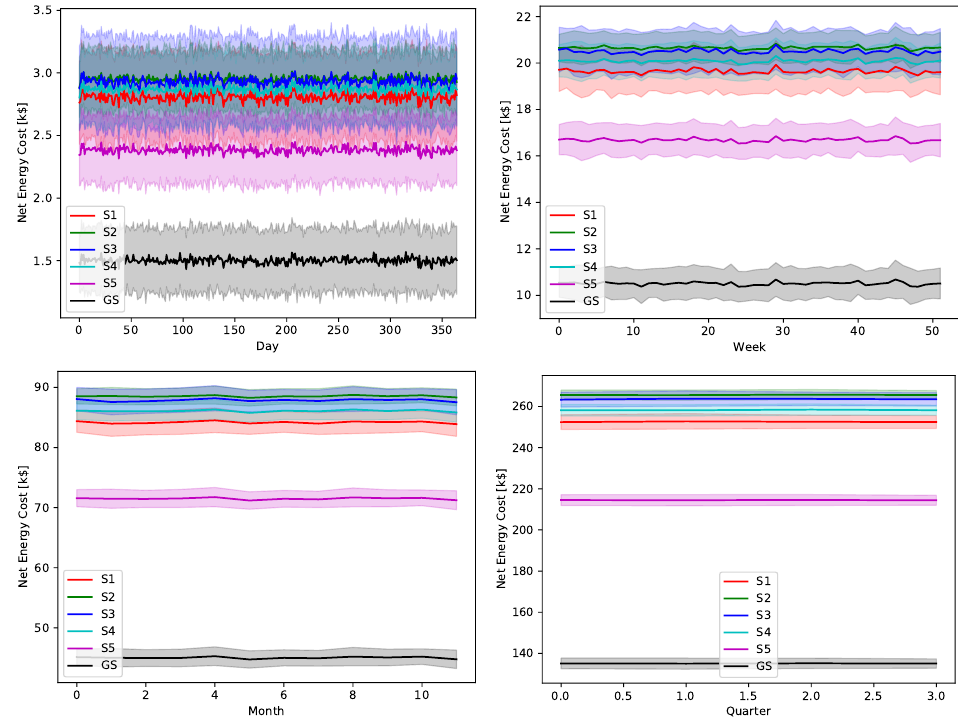
Figure 22. The total operation cost in terms of net energy purchase and sell revenue with a global certainty level U 95